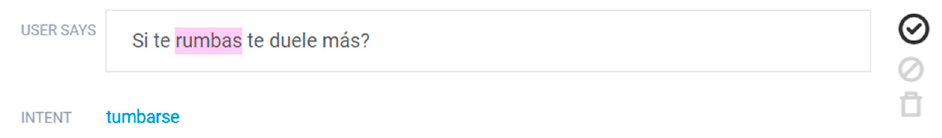
Figure 5. If the user misspelled a word and the AI was able to identify that it was an error and associate it with the correct intent.